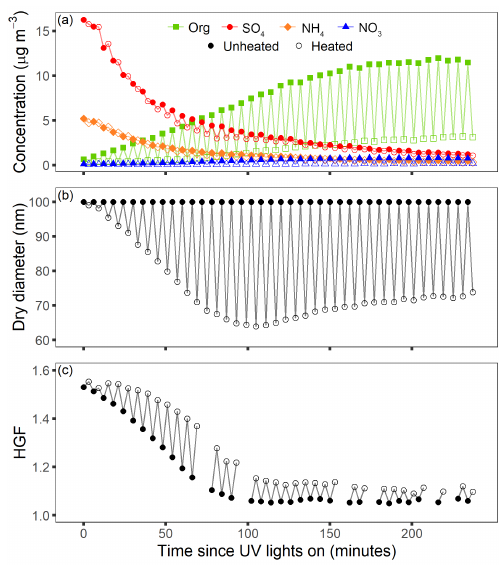
Figure 4. Alternating direct measurements of unheated and heated aerosol properties during 4h of α -Pinene SOA formation on AS seed particles, demonstrating decreases in (a) bulk non-refractory mass concentration and (b) dry particle diameter, and (c) the corre- sponding increases in HGF after removal of a semi-volatile fraction at 120 ◦ C. Gaps in the HGF data are due to faulty H-SMPS mea- surements which have been